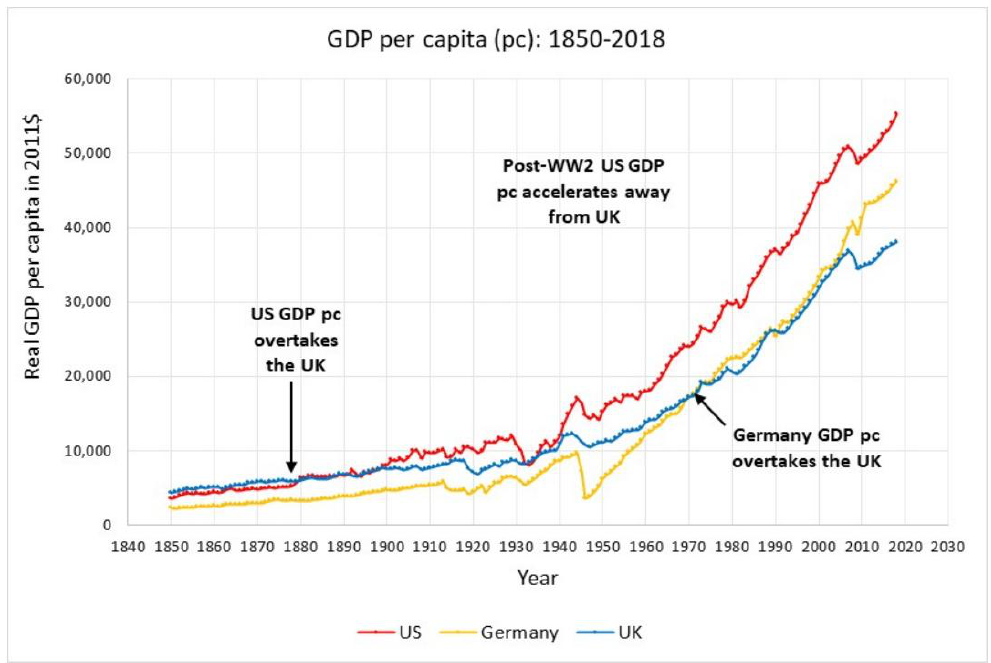
Figure 3. Comparative Growth: UK performance relative to major rivals, the US and Germany.